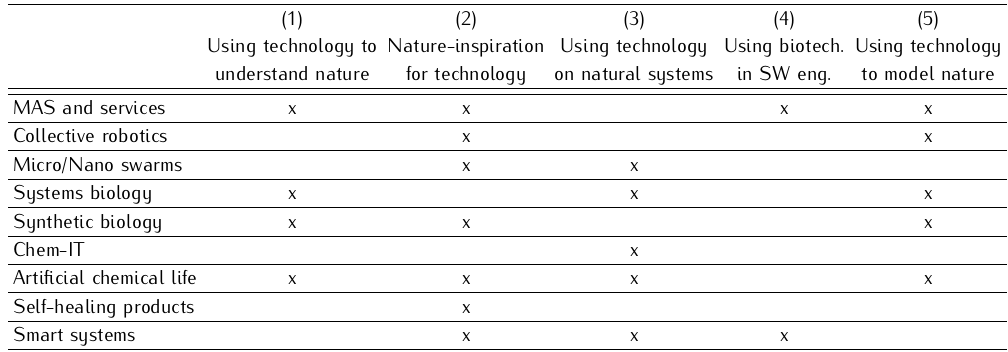
Table 3 indicates how complexity engineering